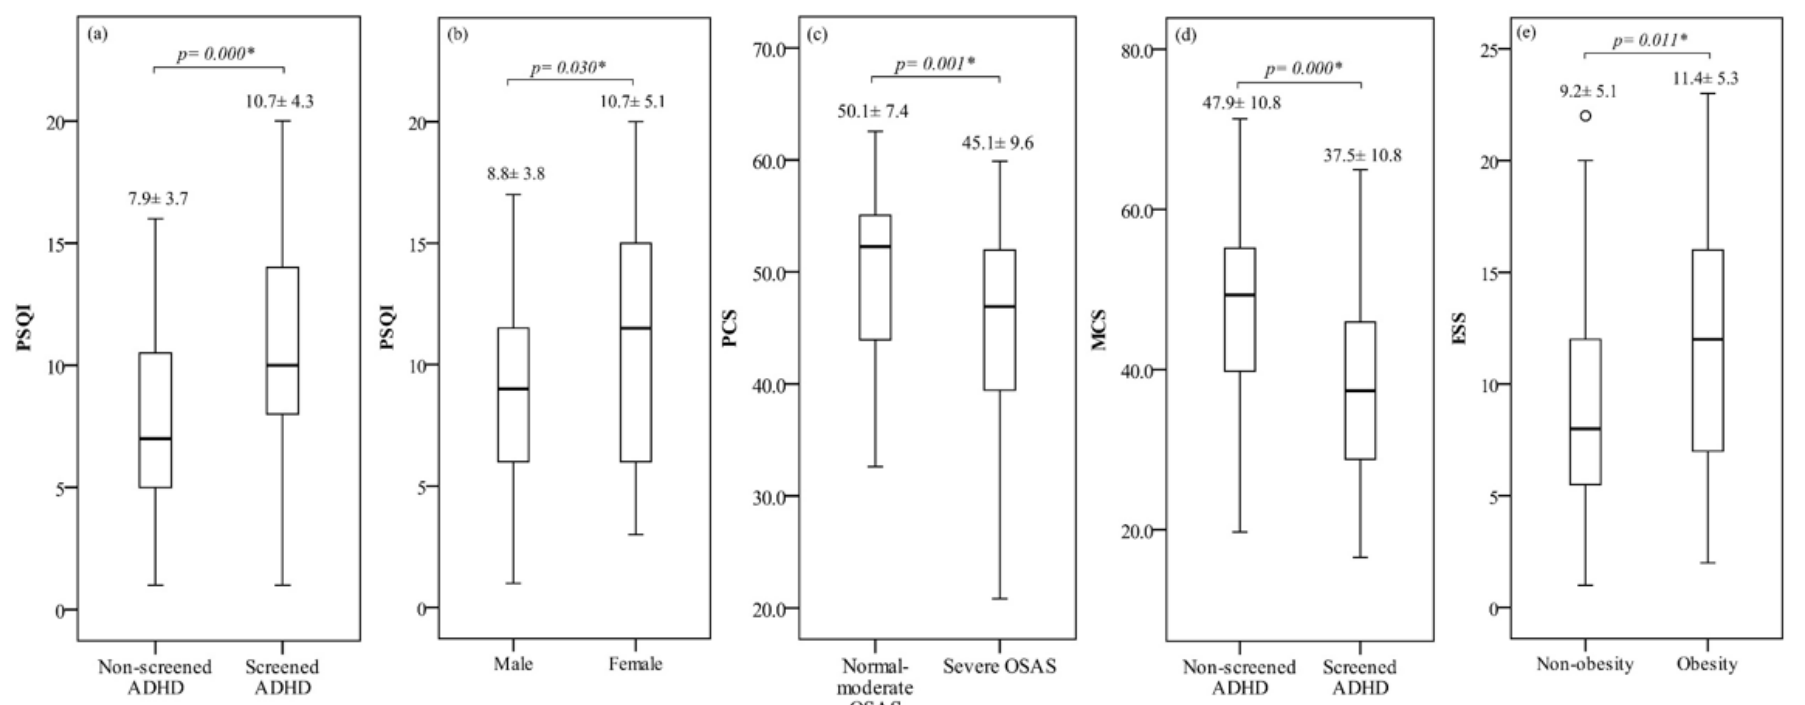
Figure 2. The significant results of HRQoL by the studied features with ( a ) PSQI by screened ADHD, ( b ) PSQI by sex difference, ( c ) PCS by OSAS severity, ( d ) MCS by screened ADHD, and ( e ) ESS by obesity. Abbreviations: ADHD, attention-deficit/hyperactivity disorder; ESS, Epworth Sleepiness Scale; MCS, mental component score; OSAS, obstructive sleep apnea syndrome; PCS, physical component score; PSQI, Pittsburgh Sleep Quality Index. * p < 0.05.